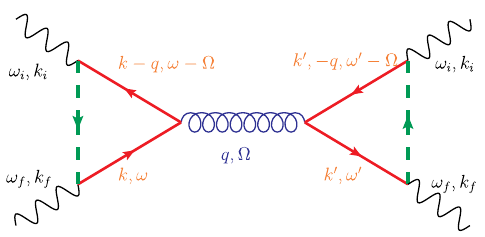
FIG. 2. Leading-order one-phonon contribution to RIXS. The dotted lines denote the Cu 2 p hole, solid lines denote the 3 d conduction electrons, and the circular line denotes the phonon. Notation for the vertices has been